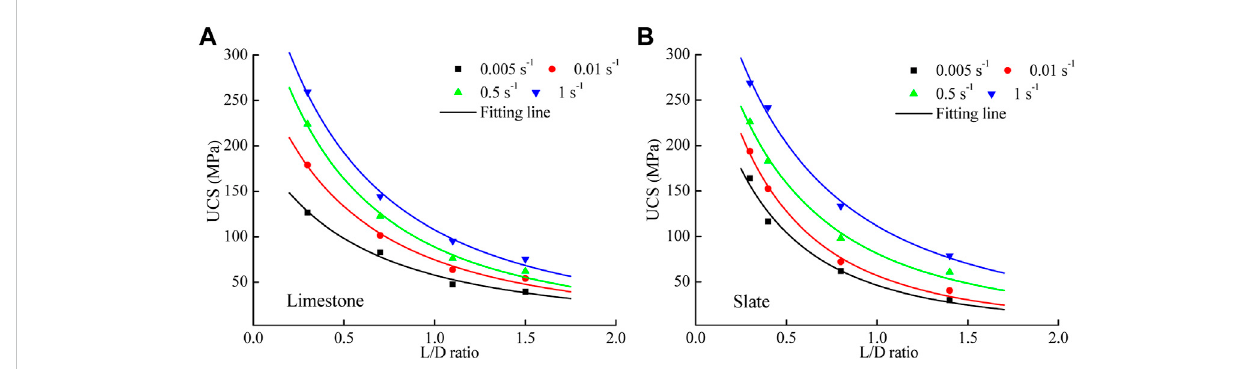
FIGURE 5 Relationship between the UCS and the L/D ratio for (A) limestone and (B)